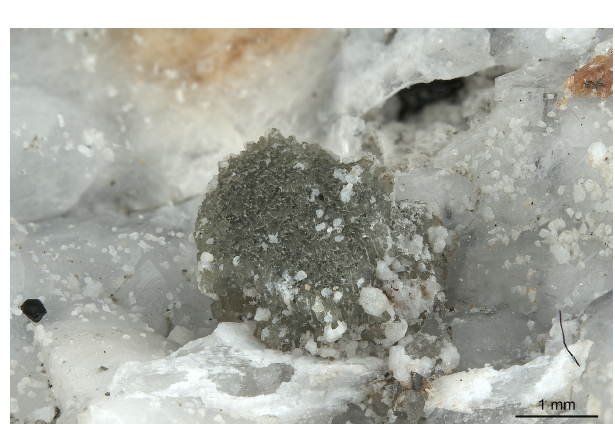
Figure 2. Green hemimorphic donnayite-(Y) crystal. FOV 9mm. Specimen CMNMC 90405. Photo: François